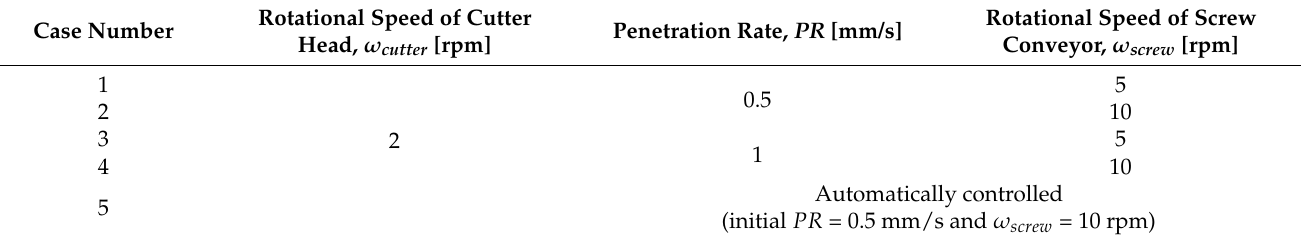
Table 6. Numerical simulation cases with different TBM operational